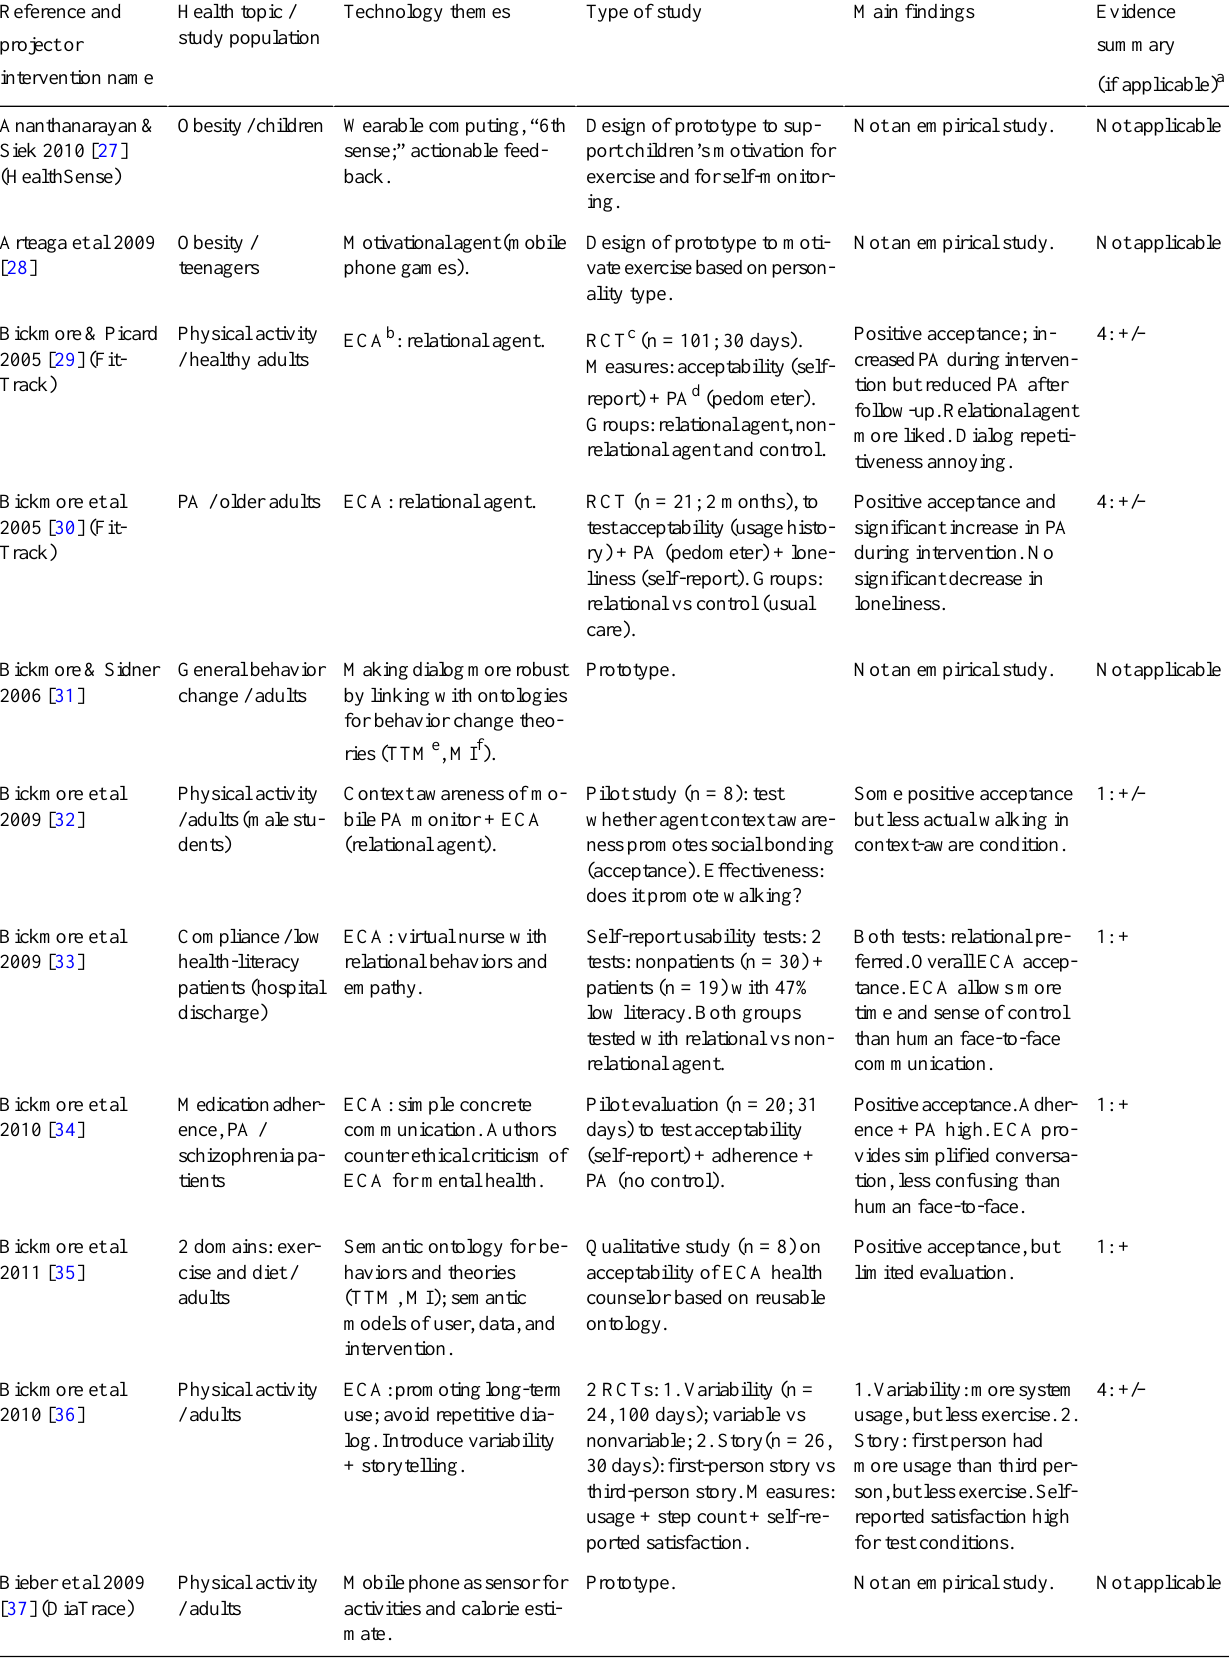
Table 1. Technology themes, study types, and main